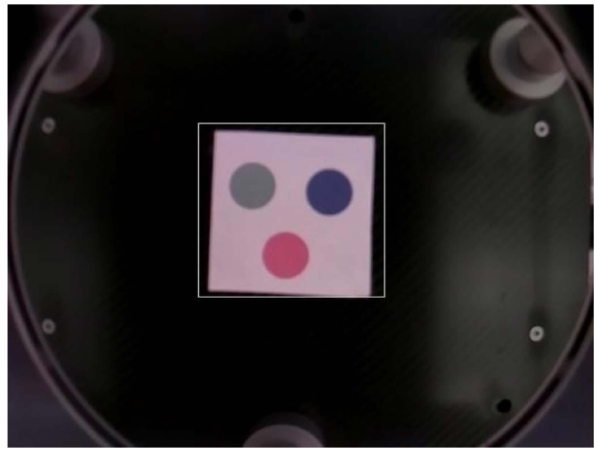
Figure 18. Marker recognition for docking.